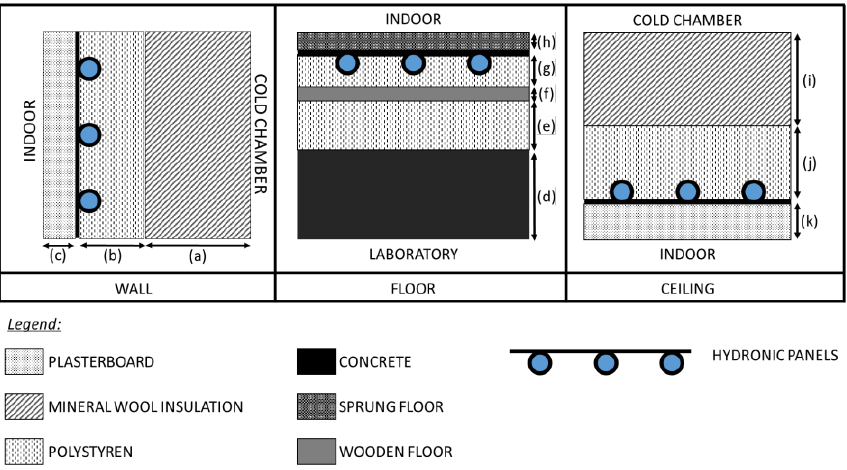
Figure 3. Envelope composition of the test chamber.